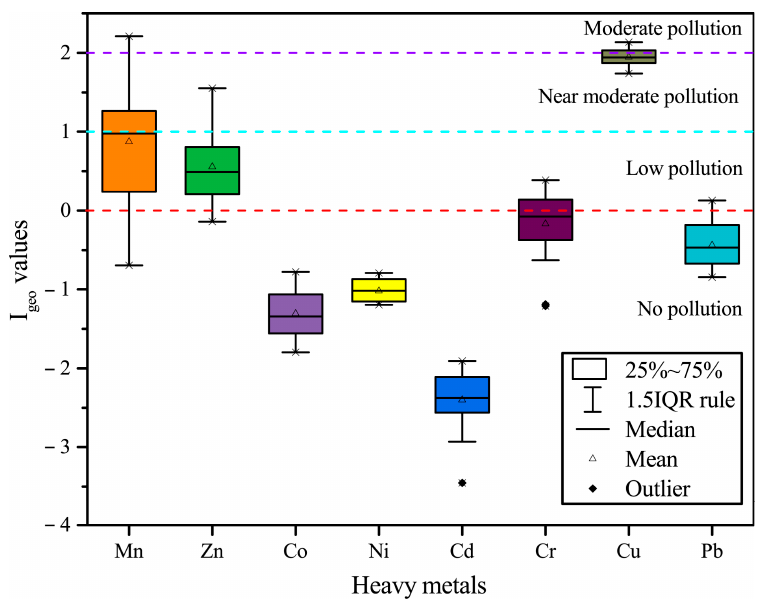
Figure 4. Geo-accumulation index (I geo ) values of heavy metals in surface sediments from the Qinjiang River.